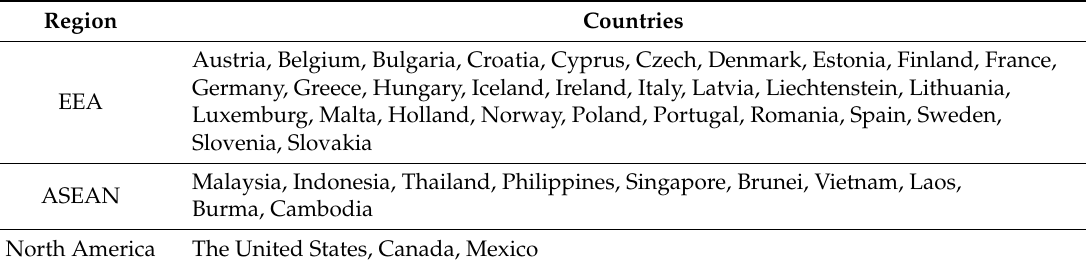
Table 7. Member countries in EEA, ASEAN and North America.